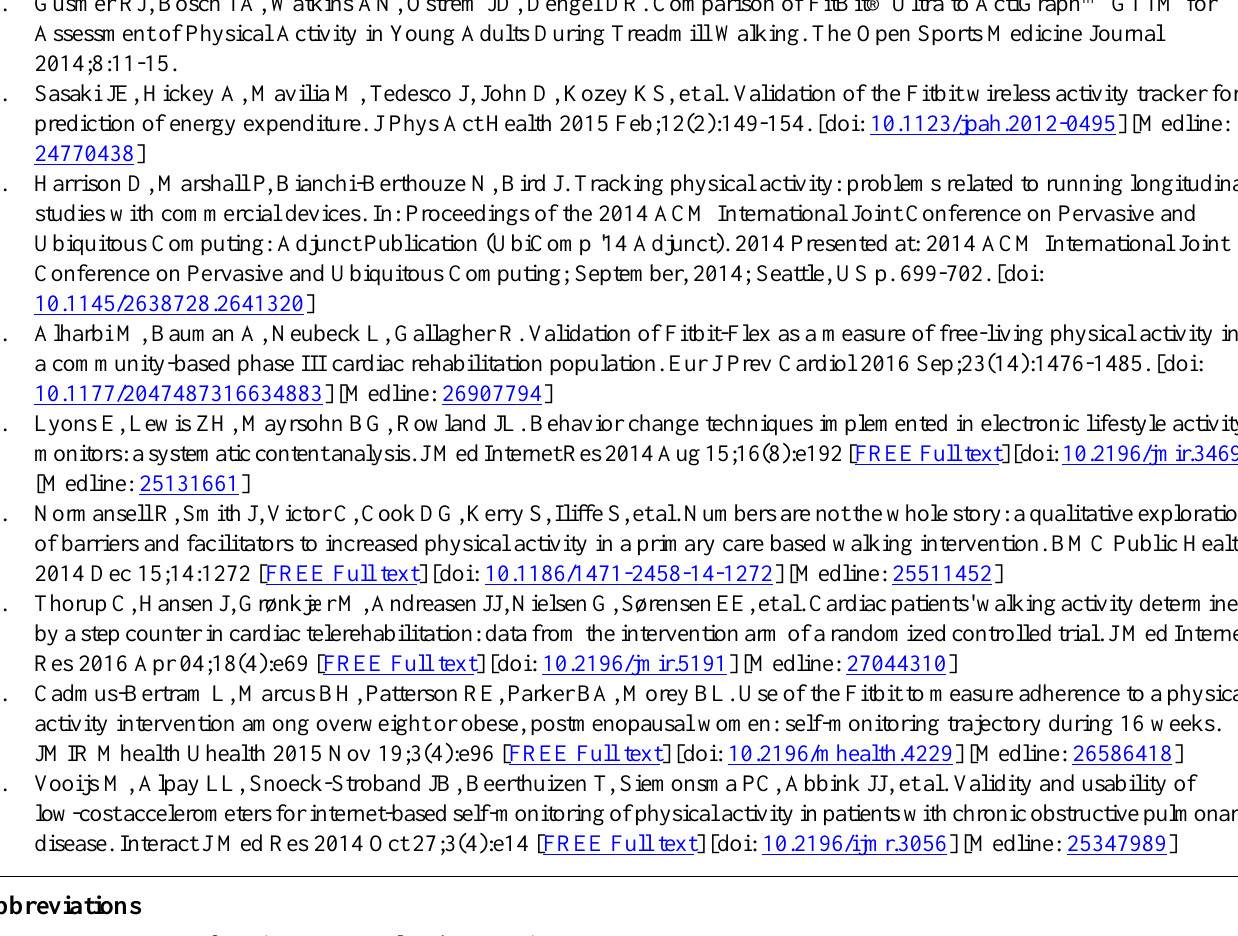
CDC: Centers for Disease Control and Prevention IQR: interquartile